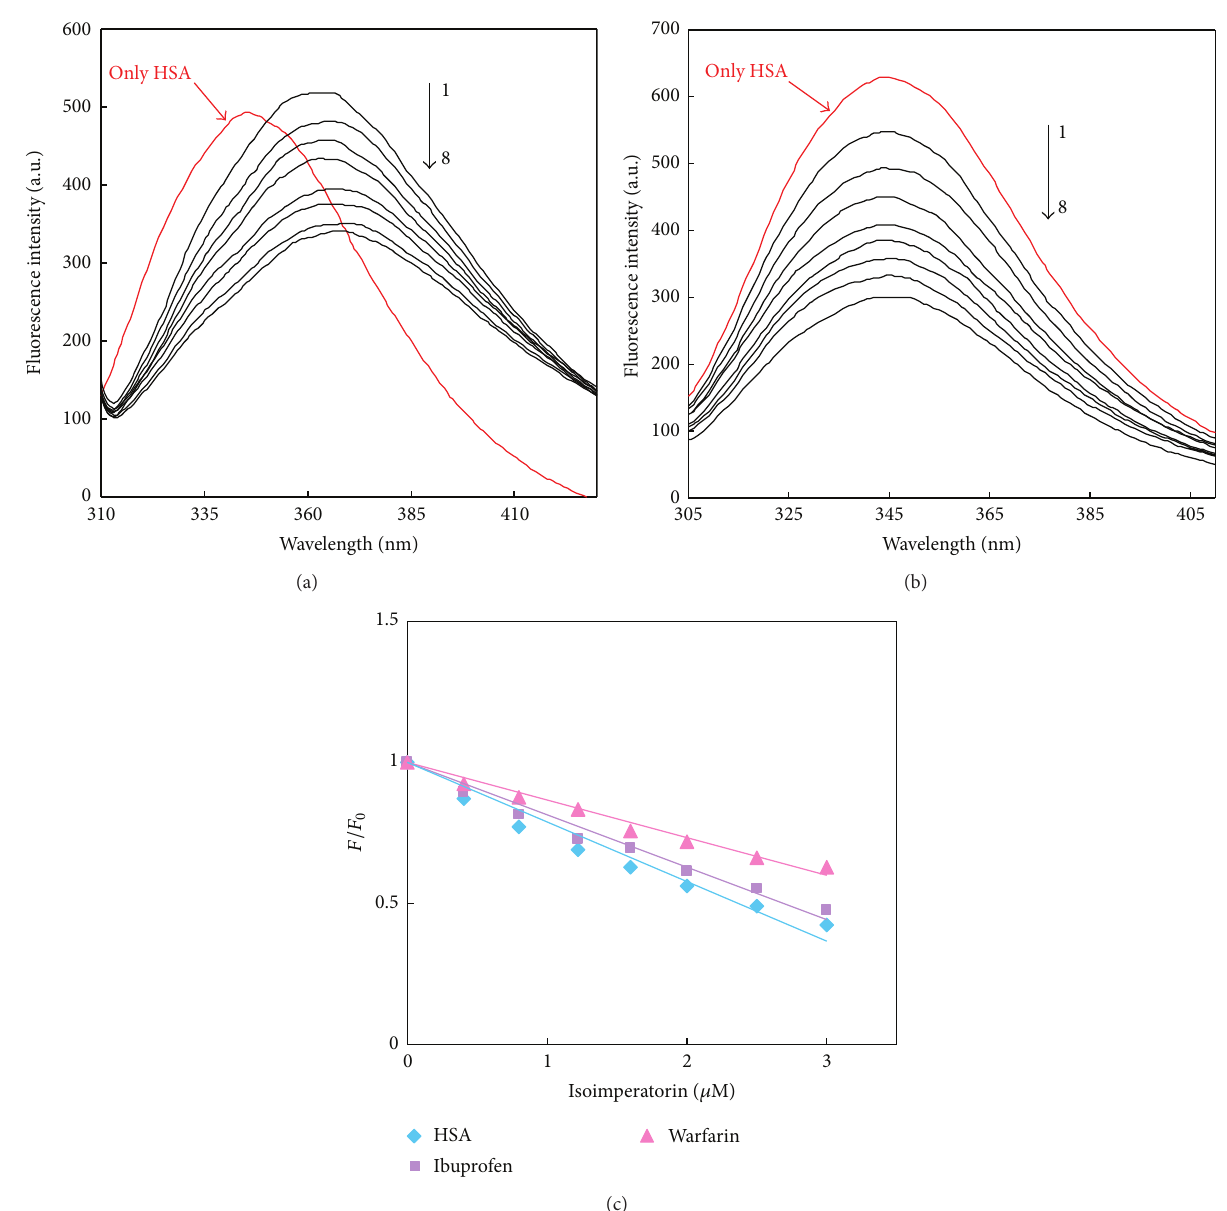
Figure 10: Effect of isoimperatorin on the quenching of HSA-warfarin complex (a) and HSA-ibuprofen complex (b) fluorescence. From 1 to 8: [HSA] = [warfarin or iboprufen] = 3 𝜇 M, [isoimperatorin] = 0, 0.4, 0.8, 1.2, 1.6,2, 2.5, and 3 𝜇 M. All reproduced data shown are representative of at least 3 independent experiments. (c) Fluorescence quenching profiles of HSA ( ⧫ ), HSA-ibobrofen ( ◼ ), and HSA-warfarin ( 󳵳 ) in the presence of various concentration of